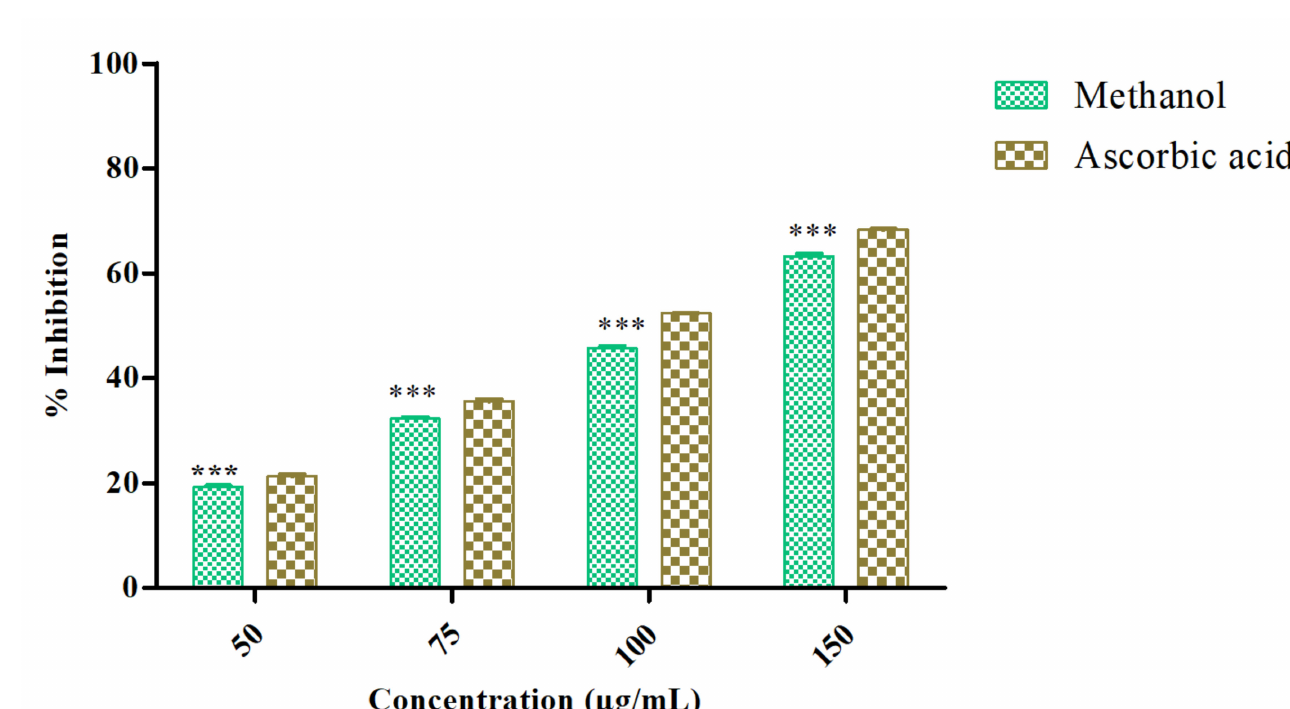
Figure 1. DPPH radical-scavenging ability of methanol extract of Azima tetracntha. The values are Mean ± SD. One-way ANOVA was used to analyze the significant difference among groups. The symbol (***) indicate the significant difference ( p < 0.001).